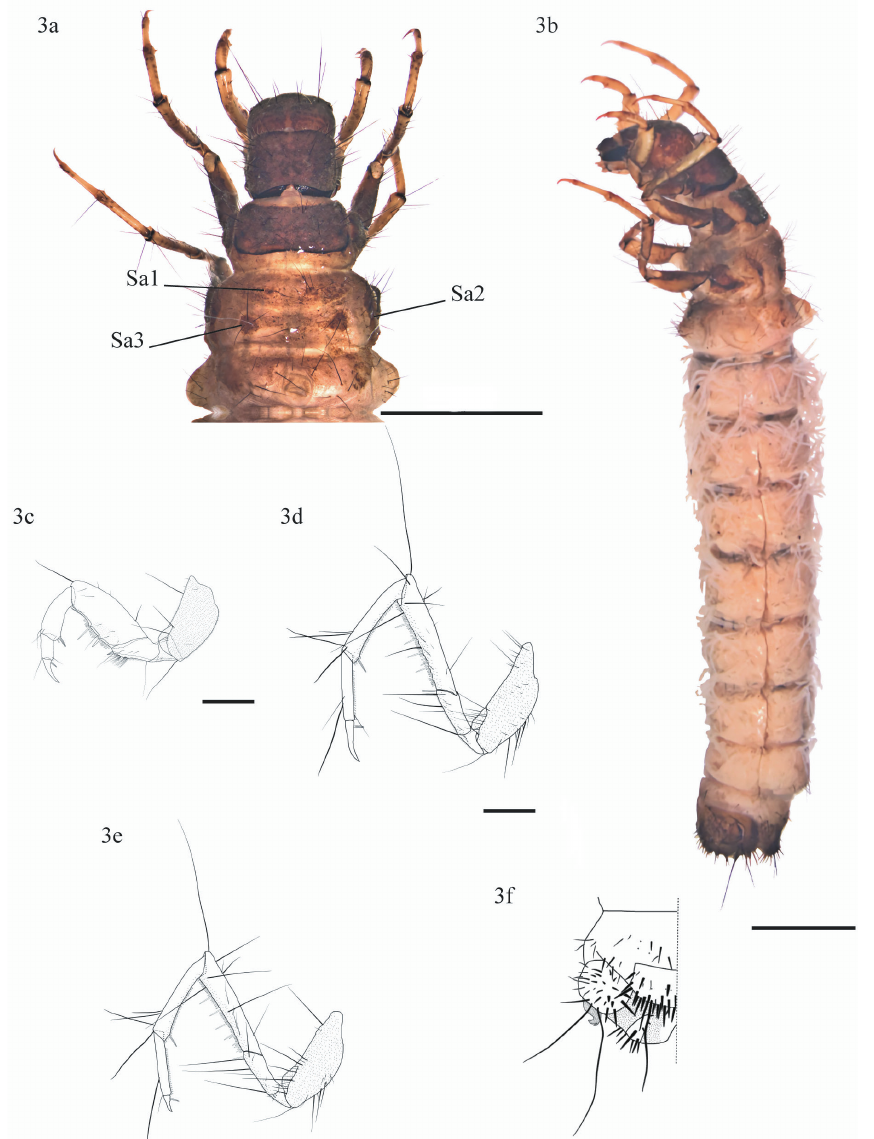
Figure 3. Verger lutzi larva. (a) Head, thorax and first abdominal segments, dorsal. (b) Habitus,